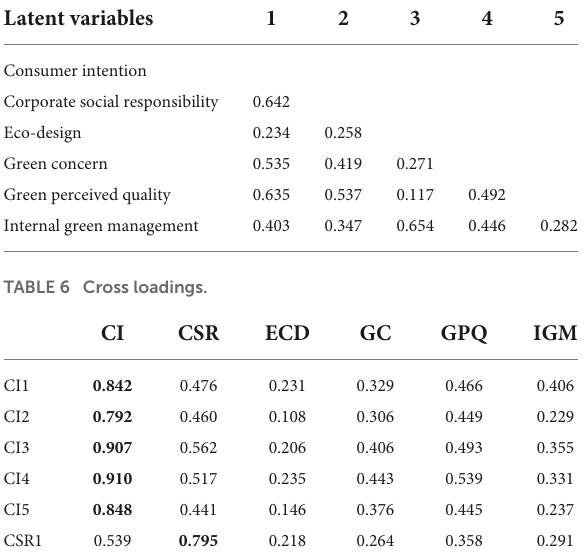
TABLE 7 Hypotheses